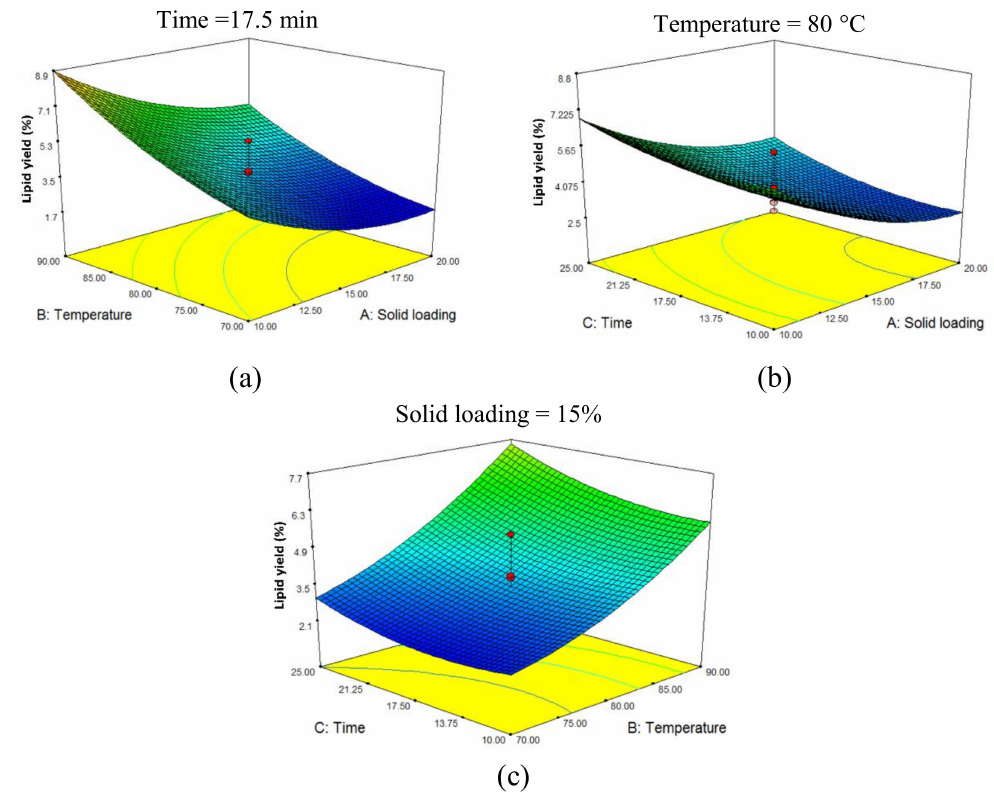
Figure 6. Response surface plots displaying the e ff ect of ( a ) microwave solid loading and extraction temperature, at Time = 17 min ( b ) microwave solid loading and extraction time, at Temperature = 80 ◦ C and ( c ) the extraction temperature and time at Solid loading = 15% on lipid extraction